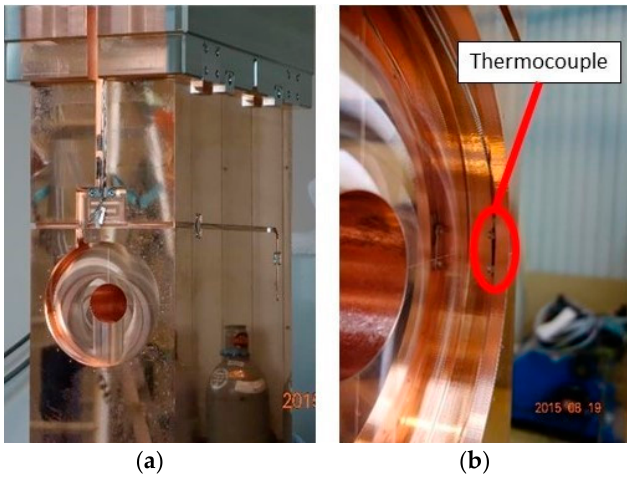
Figure 5. Pictures of ( a ) one of the new scrapers (SCs); and ( b ) the region near the thermocouple.